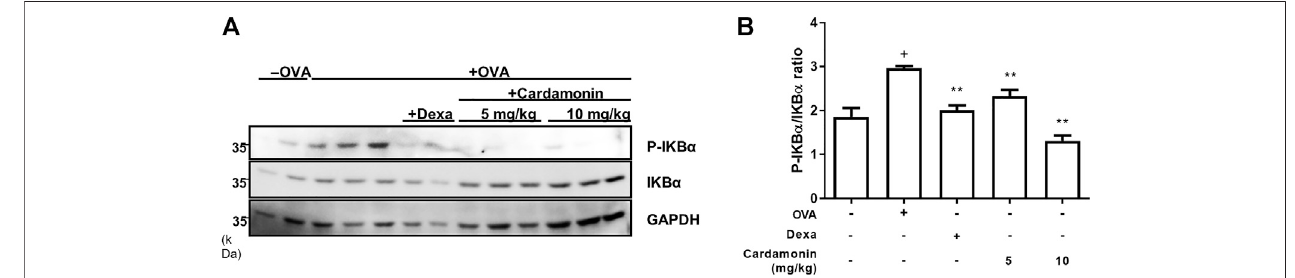
FIGURE 6 | Effect of cardamonin on phosphorylation of IkB α in OVA-induced allergic airway in fl ammation model in BALB/c mice . Western blotting was used to detect phosphorylated and total IkB- α levels in lung tissue from mice in the sham group, and the OVA-sensitized and OVA re-challenged mice treated with vehicle, dexamethasone (1 mg/kg), or cardamonin (5 and 10 mg/kg) (A) . The quantitative results are shown in (B) . The values presented are means ± SEM. n (cid:1) 3 – 6; + p < 0.05 compared with the sham group; * p < 0.05, ** p < 0.01 compared with the vehicle group treated with